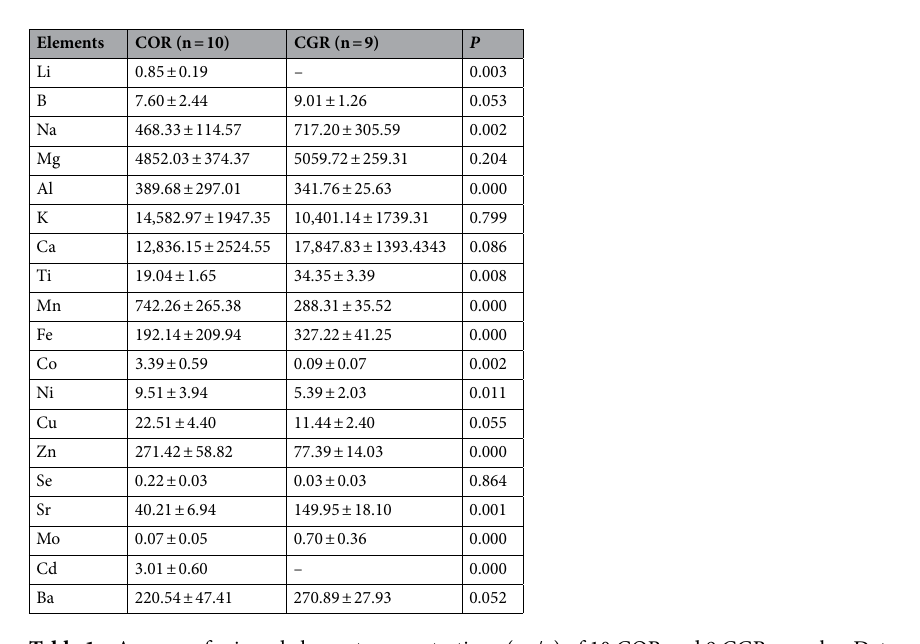
(Fig. 3d). There were significant differences in the mean value of N%, δ 15 N, and δ 13 C according to botanic origins (all P < 0.01 from T -test). The 3D scatter plot of N%, δ 15 N, and δ 13 C values was presented in Fig. 4, and it exhibited the excellent ability to predict COR and CGR. On the whole, the COR had a high N% and δ 13 C value, and a low δ 15 N value, so they gathered at the top section in the 3D graph. However, the CGR, in contrast, mainly appeared at the bottom. The stable isotope ratio shows a good effect in distinguishing different sources of Curculigo Rhizoma. Mineral element analysis. The contents of mineral elements in COR and CGR samples were shown in Table 1. The results appeared significantly different among the two source species, except for B, Mg, K, Ca, Cu, Se, Ba. The K and Ca were the most abundant inorganic elements in COR and CGR. The Li, Al, Mn, Co, Ni, Zn and Cd contents were higher in COR than in CGR, while the concentrations of Na, Ti, Fe, Sr and Mo elements were present at a lower level in the COR samples.